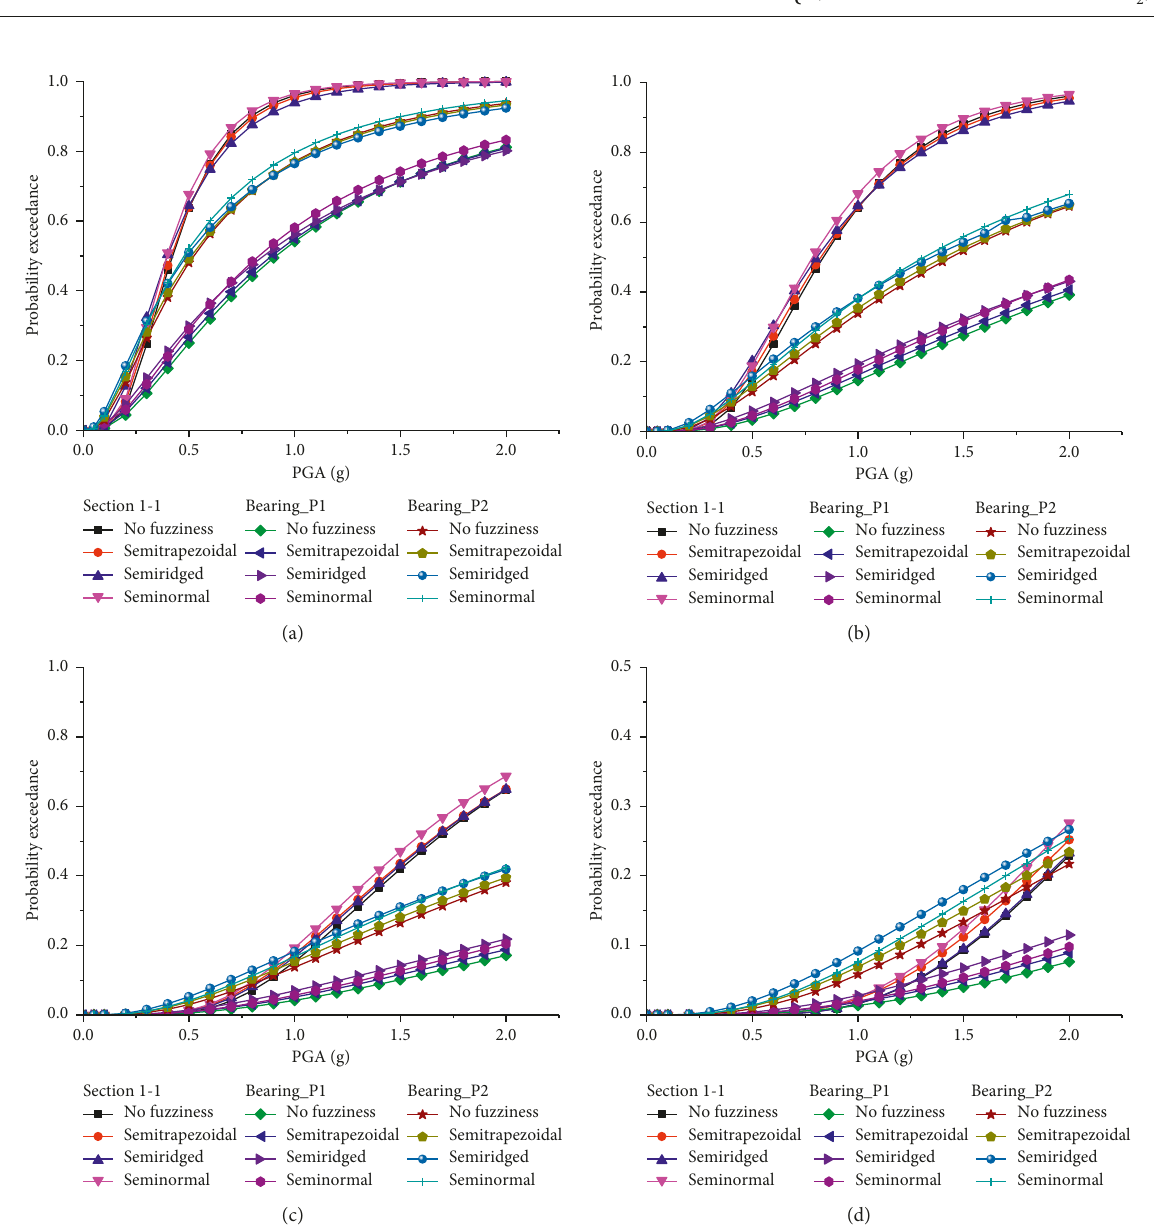
Figure 8: Fragility curves based on fuzzy failure criteria. (a) Slight damage. (b) Moderate damage. (c) Extensive damage. (d) Complete